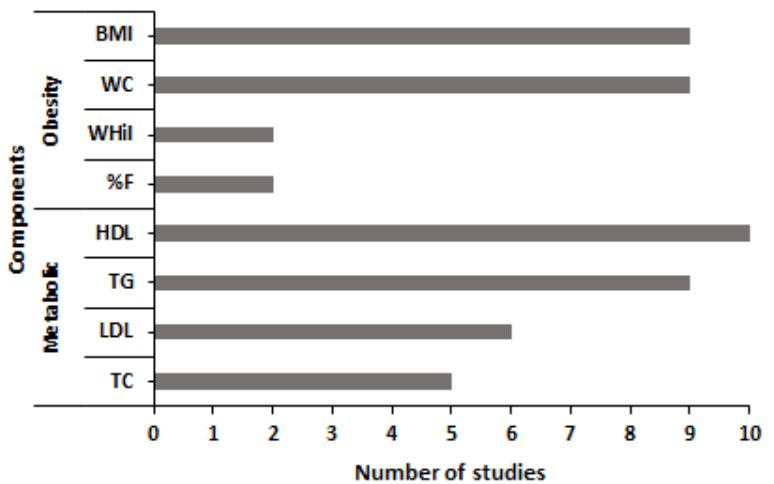
Figure 2. Components of the metabolic syndrome used to assess adults living in high-altitude regions (BMI: Body Mass Index, WHiI: Waist hip index, WC: waist circumference, WHeI: waist height index, BP: blood pressure, SG: serum glucose, TC: total cholesterol, TG: triglycerides, %F: body fat percentage; HDL: high-density lipoprotein, LDL: low-density lipoprotein).